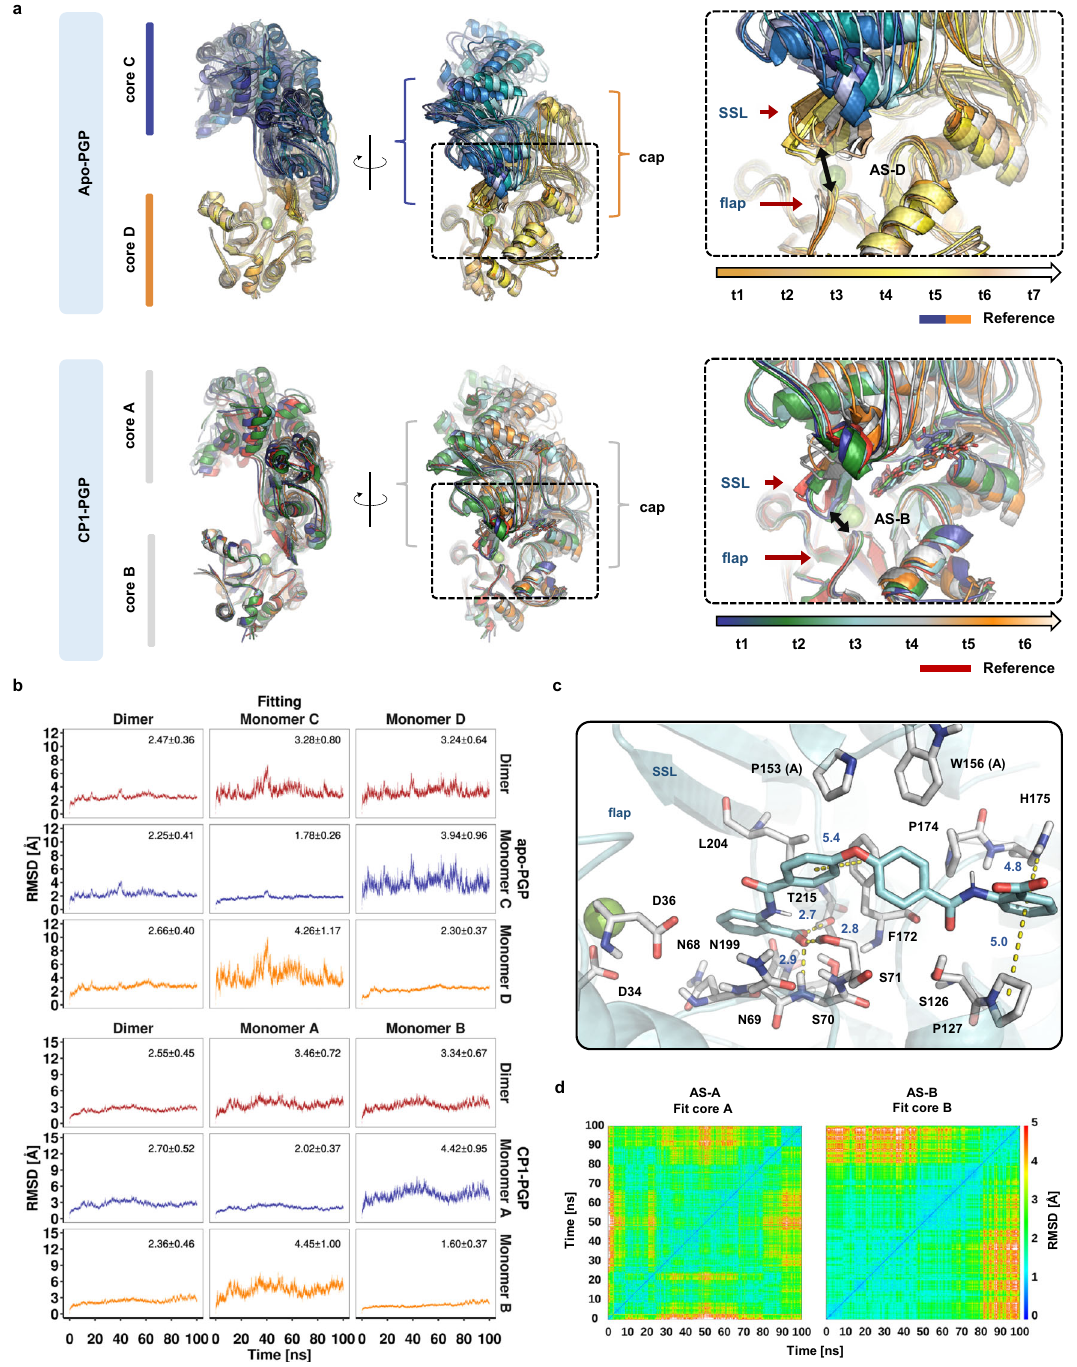
Fig. 4 | CP1 maintains PGP in a cap-closed state during MD simulation. a Superposition of apo-PGP (upper panel) and CP1-PGP (lower panel) conforma- tions along the trajectory, using core residues of monomer D (apo-PGP) or monomer B (CP1-PGP) for alignment. Snapshots were taken from speci fi c time intervals in which the protein adopted distinct conformations. The sampled con- formationsfromdifferenttimepoints(t 1 tot 6/7 )arecoloredbasedonaprogressing timeline illustrated by arrows below the right panels. The global view in the left panelshowshowthecoresarestablethroughoutthesimulation,whereastheircaps and counter-chains fl uctuate. The magni fi cation of the binding site highlights a closed catalytic site access gate, controlled by the substrate speci fi city loop (SSL) and fl ap domains in CP1-PGP. In contrast, the SSL has subtly shifted away from the fl ap domain in the apo-PGP structure, resulting in a broader active site. b RMSD timelines of the backbone atoms with respect to the starting structure, along with the corresponding average and standard deviation. The RMSD values were